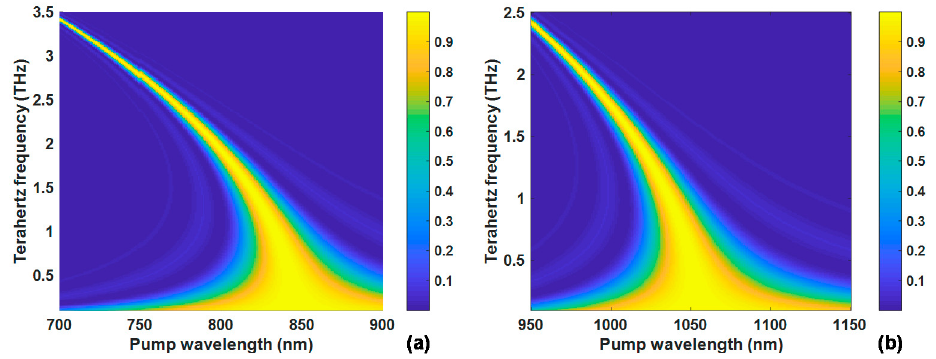
Figure 1. Relative PM efficiency of collinear DFG in ZnTe and CdTe crystals: ( a ) ZnTe and ( b ) CdTe.